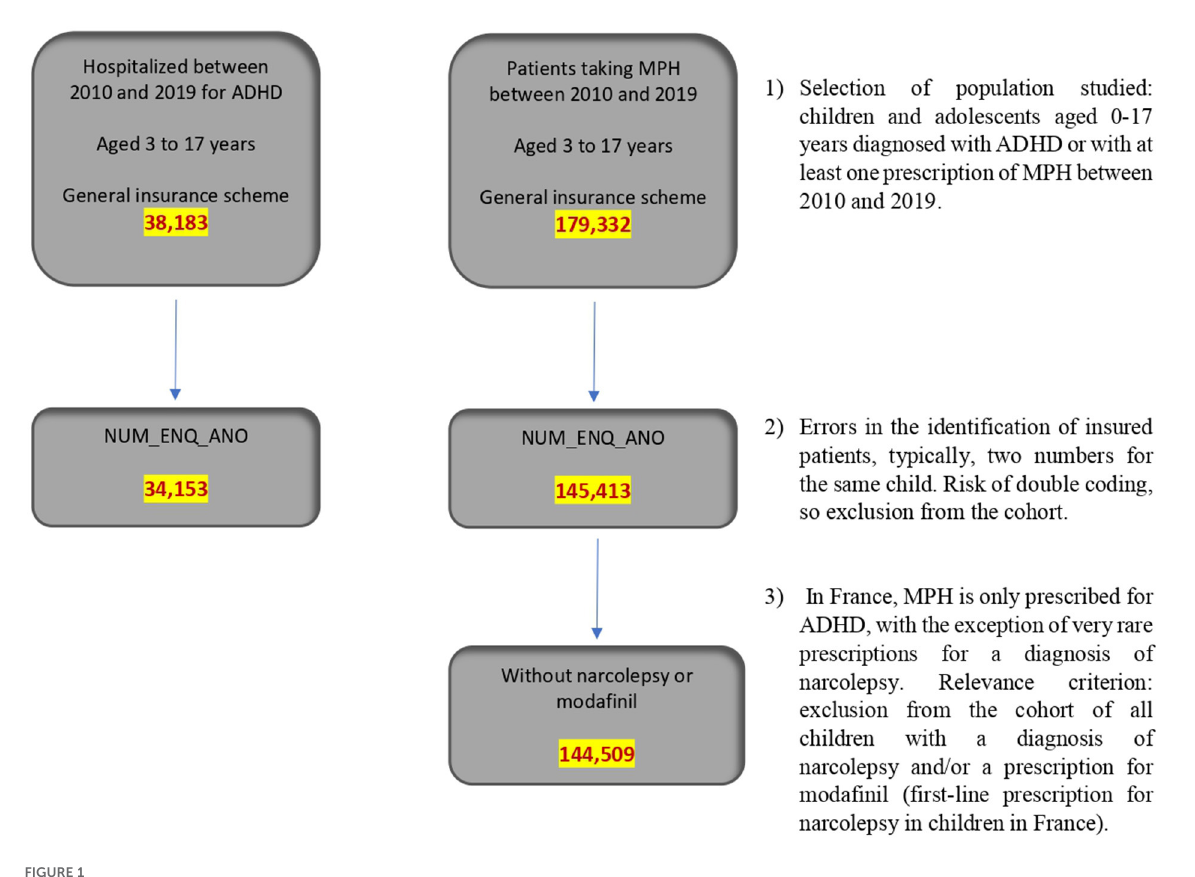
FIGURE1 Population